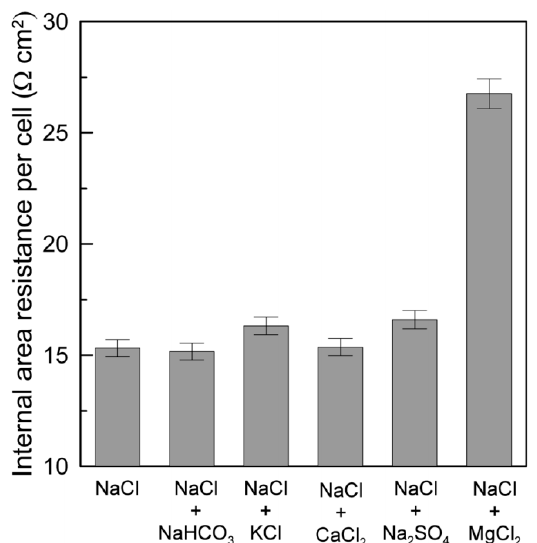
Figure 5. Variation in internal area resistance per cell with the composition of the feed solutions (single membrane area: 100 cm 2 ; number of cell pairs: 25). Reproduced with permission from [9]. Copyright 2014 Royal Society of Chemistry.